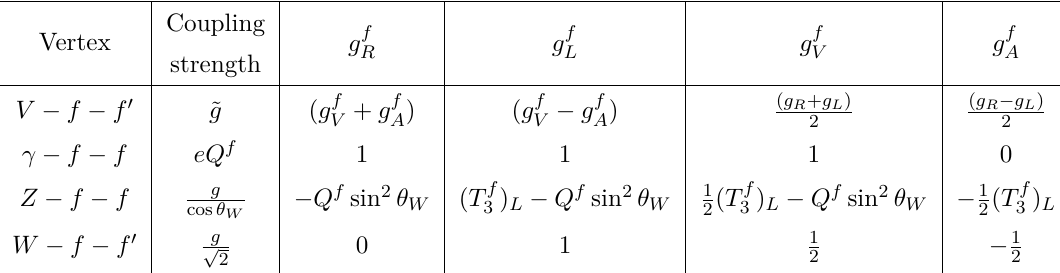
Table 1 . EW chiral couplings and coupling strength normalizations used in the EVA for fermions f, f 0 with weak isospin charge ( T f